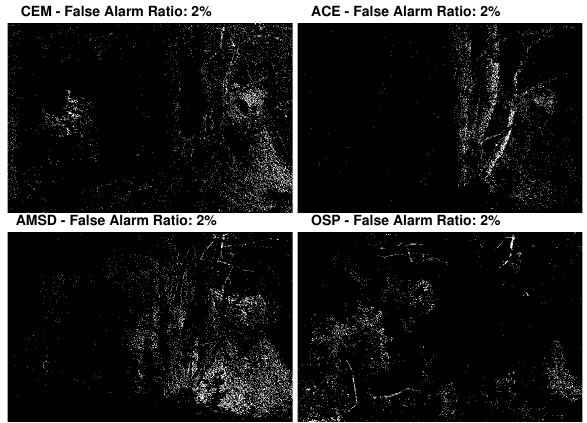
Figure 7. Detection results - concealed vehicle using 3D net